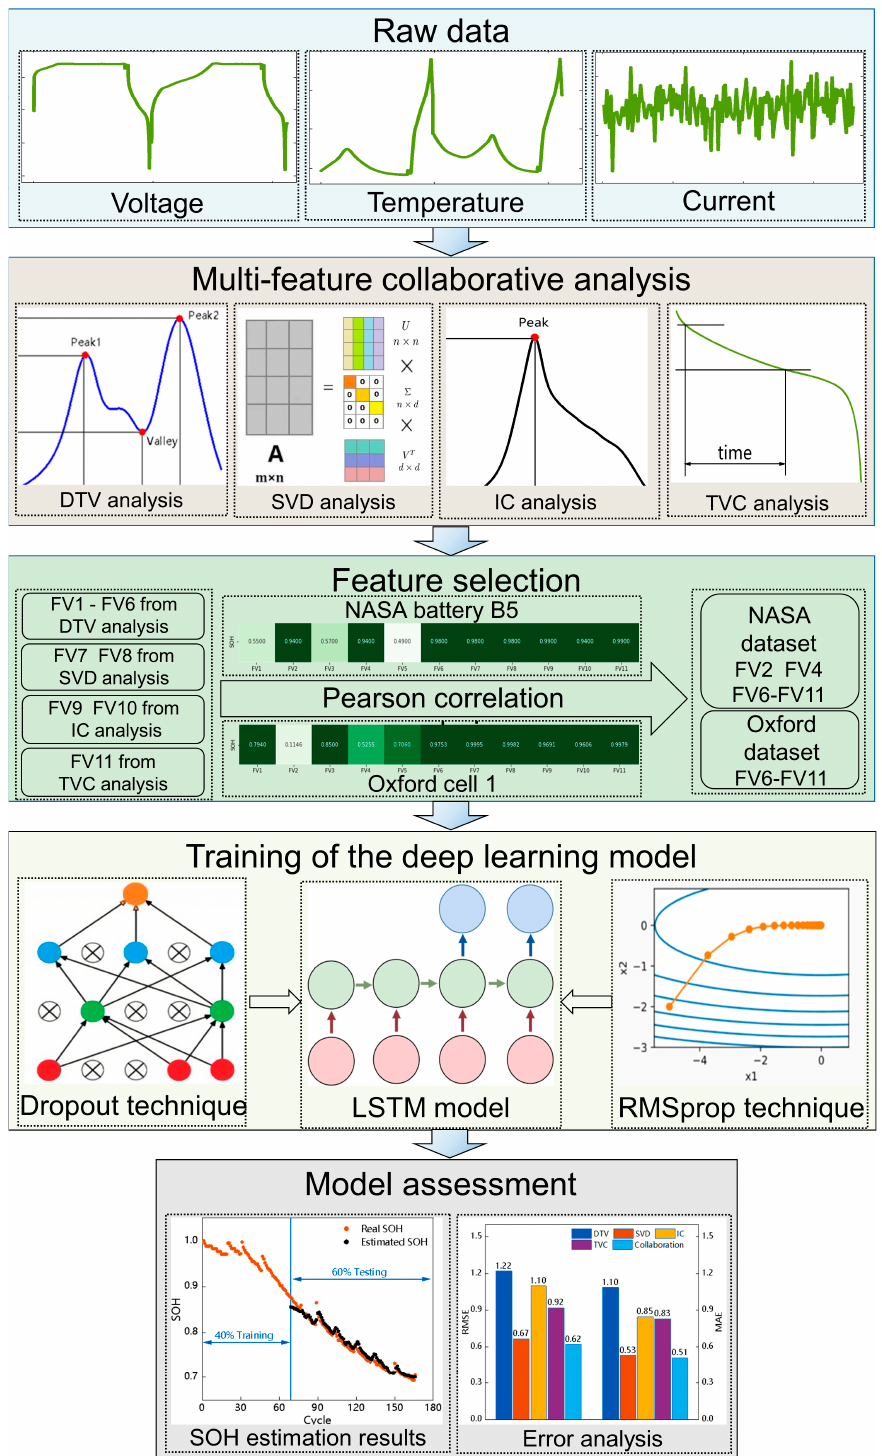
Figure 4. The flowchart of the multi-features fusion SOH prediction framework.